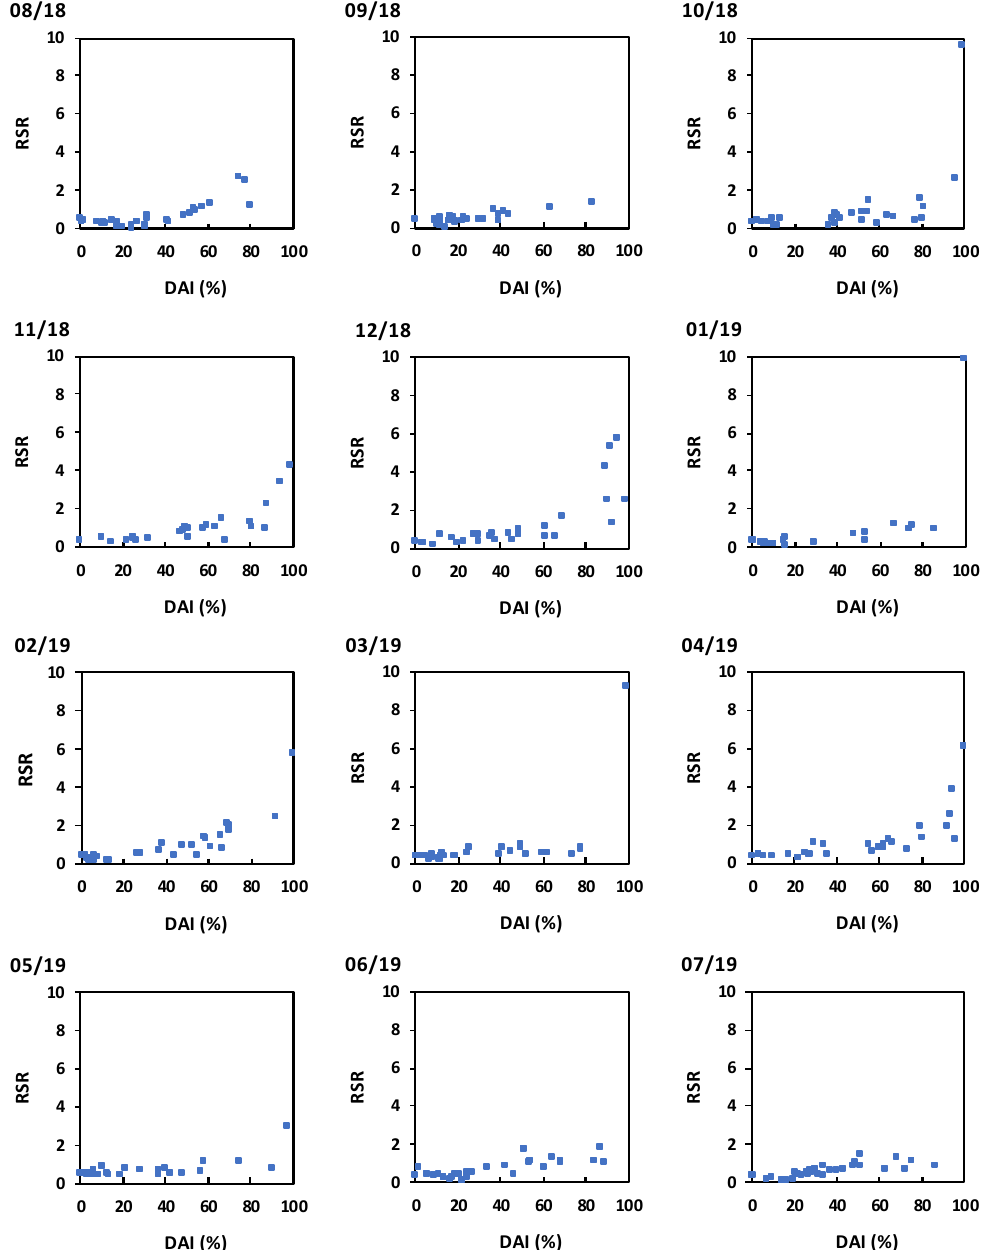
Figure 11. Relation between DAI and RMSE-observations standard deviation ratio (RSR) RSR based on hourly mean DNI forecasts and measurements for the first day of predictions between 1 August 2018 and 31 July 2019 (one year). RSR is dimensionless varying between zero and a large positive number.